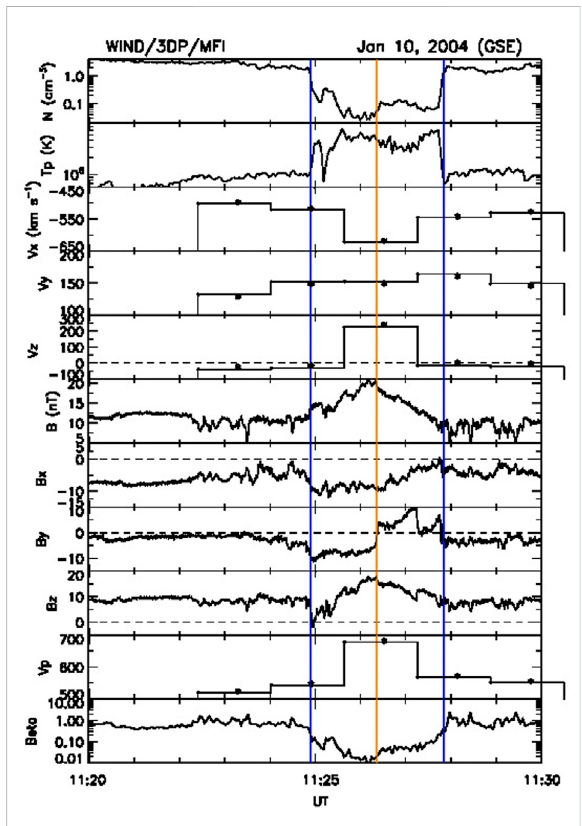
FIGURE 13 A zoom – in of the structure (bracketed by blue guidelines) in the far tail seen by Wind before the tail started to fl ap: A low- density, hot plasma is being ejected down the tail in a fl ux rope structure.ThevelocitymomentsareobtainedfromthePESA- HIGH instrument. See text for further